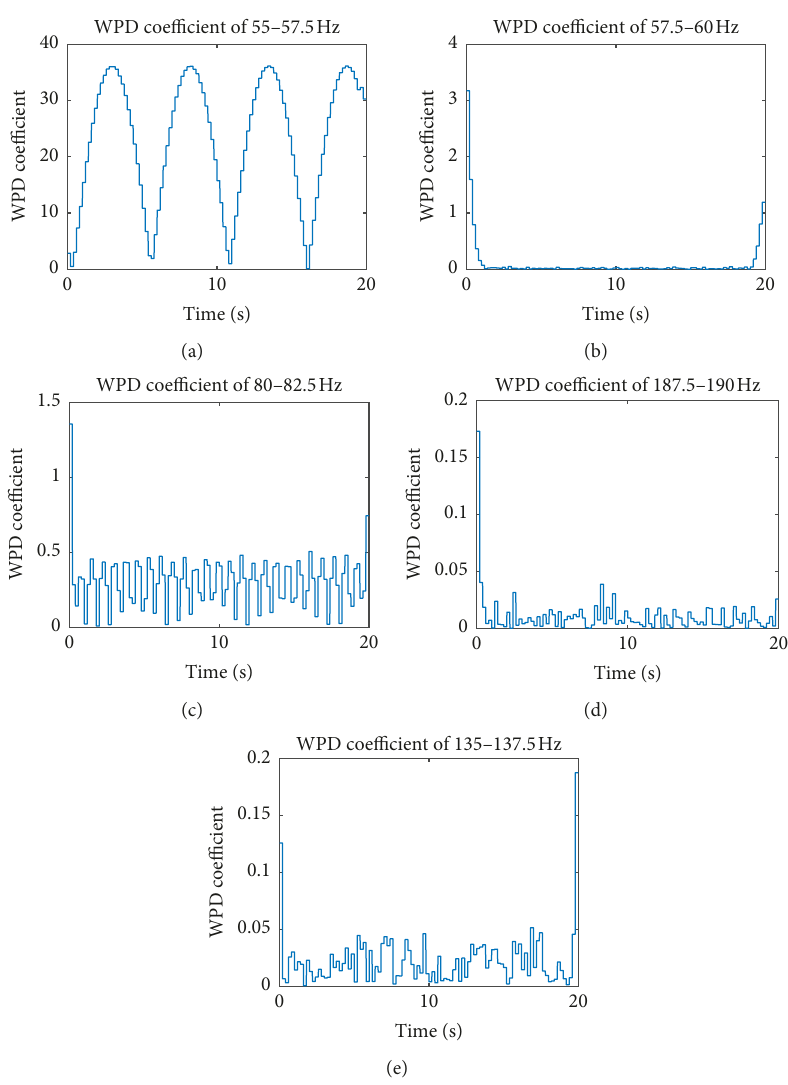
Figure 14: Wavelet coefficients related to (a) f s , (b) F BRB , (c) F MIS , (d) F ORF , and (e) F IRF under the normal